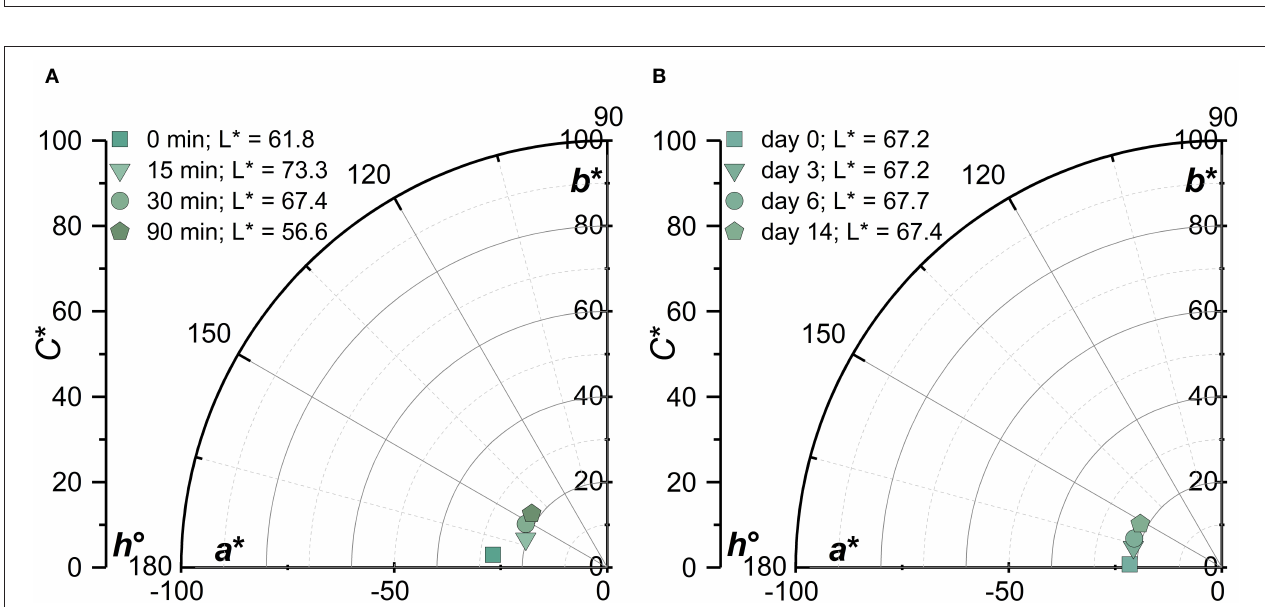
FIGURE 3 | CIE 1931 L * C * h ◦ chromaticity diagram of PC: λ C (1:4) complexes at a pH of 3 and heated to 90C as a function of (A) : λ C ultrasonication treatment time 0–90min (2,341–228 kDa) at day 14 and (B) : storage time (days 0–14).